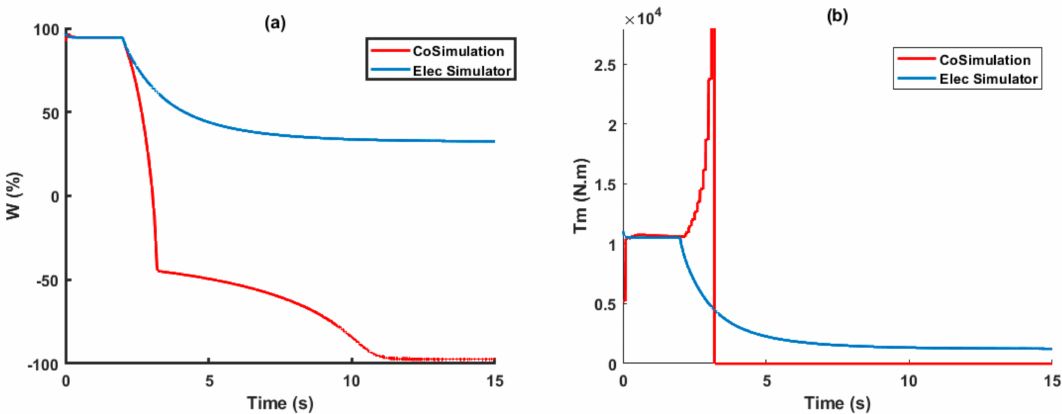
Figure 10. The simulation results of the 2 MW asynchronous motor coupled to a basic pump model in Apros; ( a ) Speed and ( b ) mechanical torque.